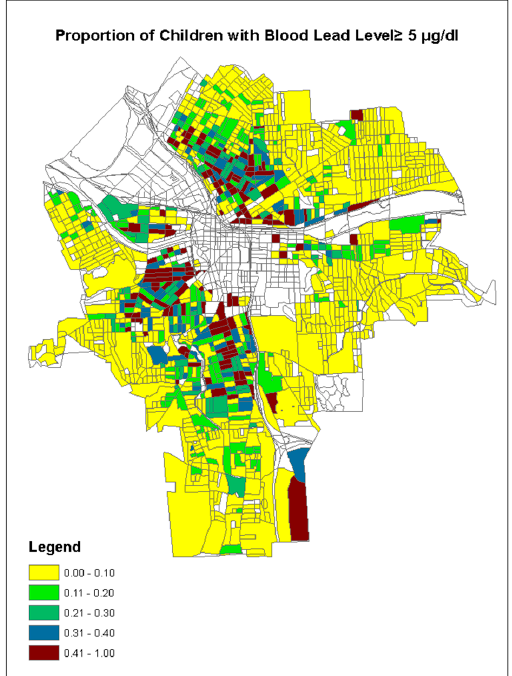
Figure 2. Geographical map of the observed incident rate of children’s BLL ≥ 5 µg/dL in the city of Syracuse, NY, USA, (the blanks are non-residential areas).